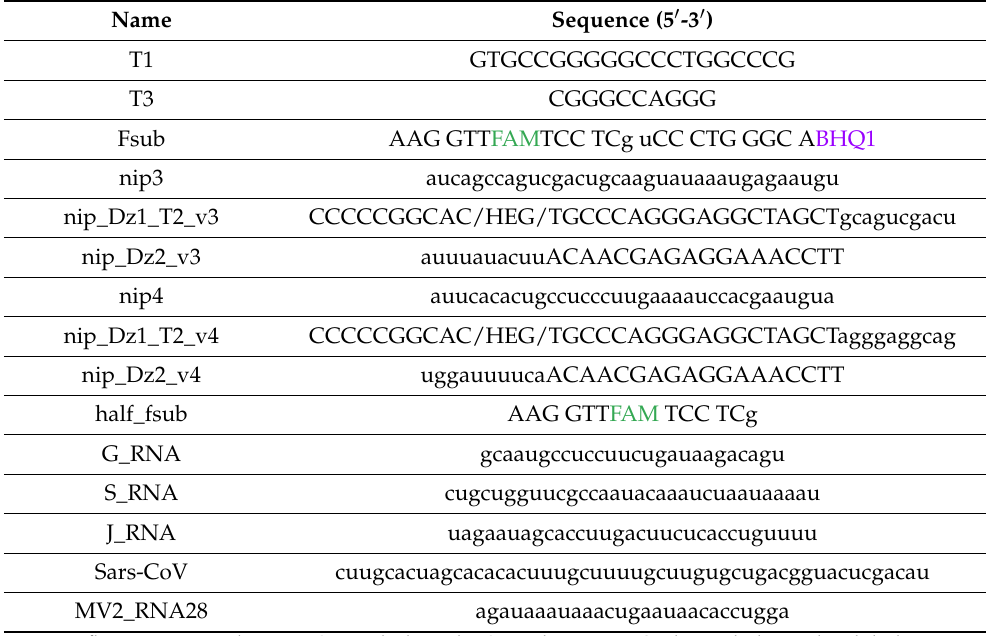
Table 1. Sequences of the oligonucleotides used in this